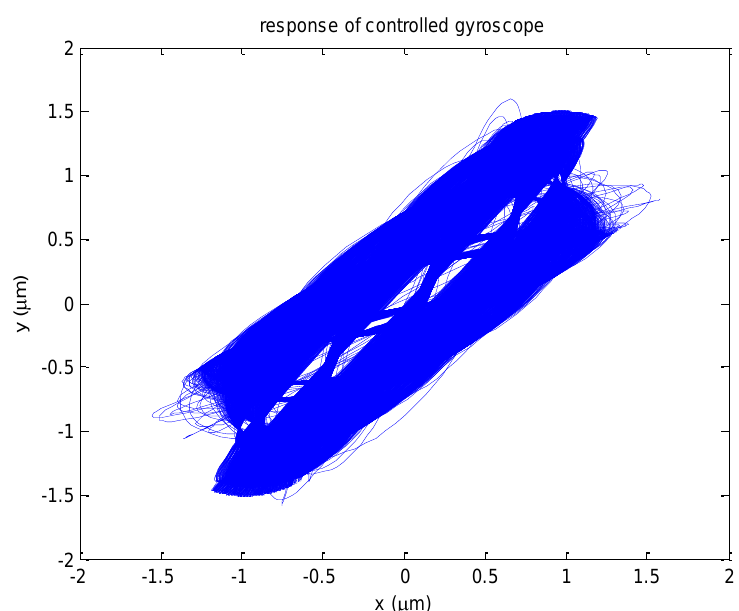
Figure 5. Trajectory of proof mass in x-y plane.